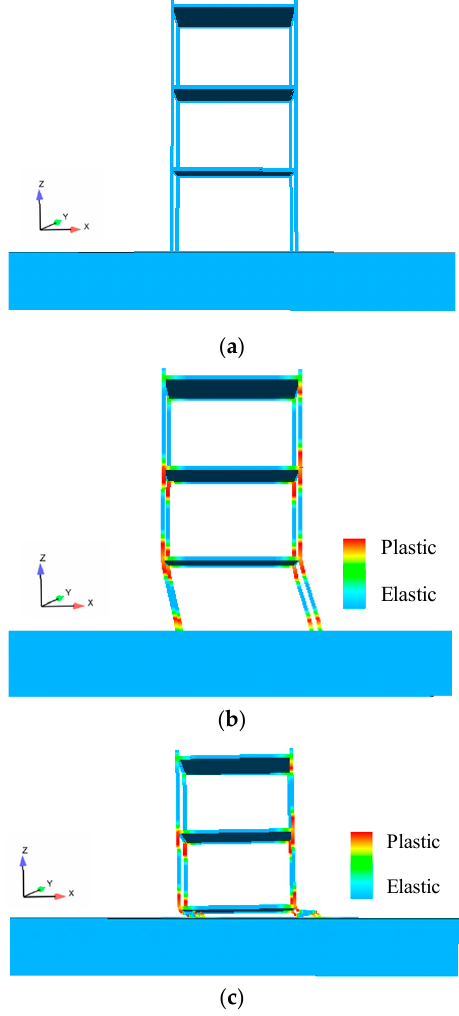
Figure 10. Collapse process of the reinforced concrete frame subjected to the El-Centro